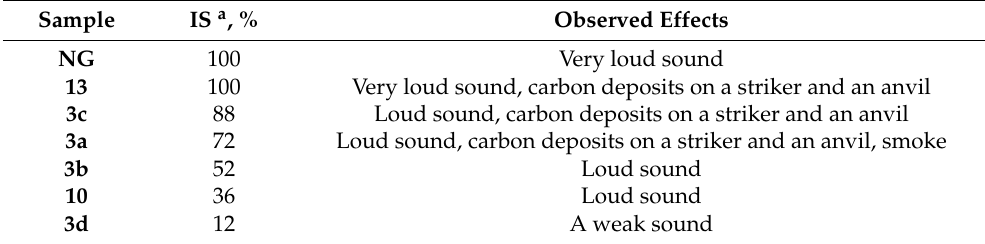
Table 1. Percentage of azide explosions during impact sensitivity testing.